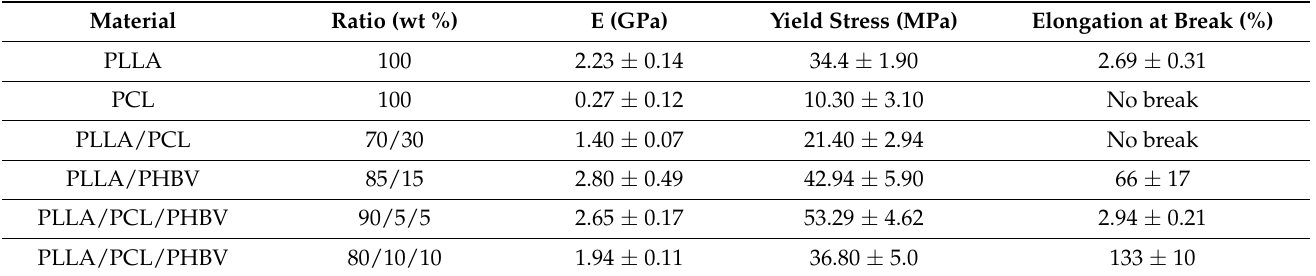
Figure 4. Representative load–displacement responses from filament tensile testing. Table 3. Mechanical properties for polymer filaments. Mean ± s.d. n = 3.